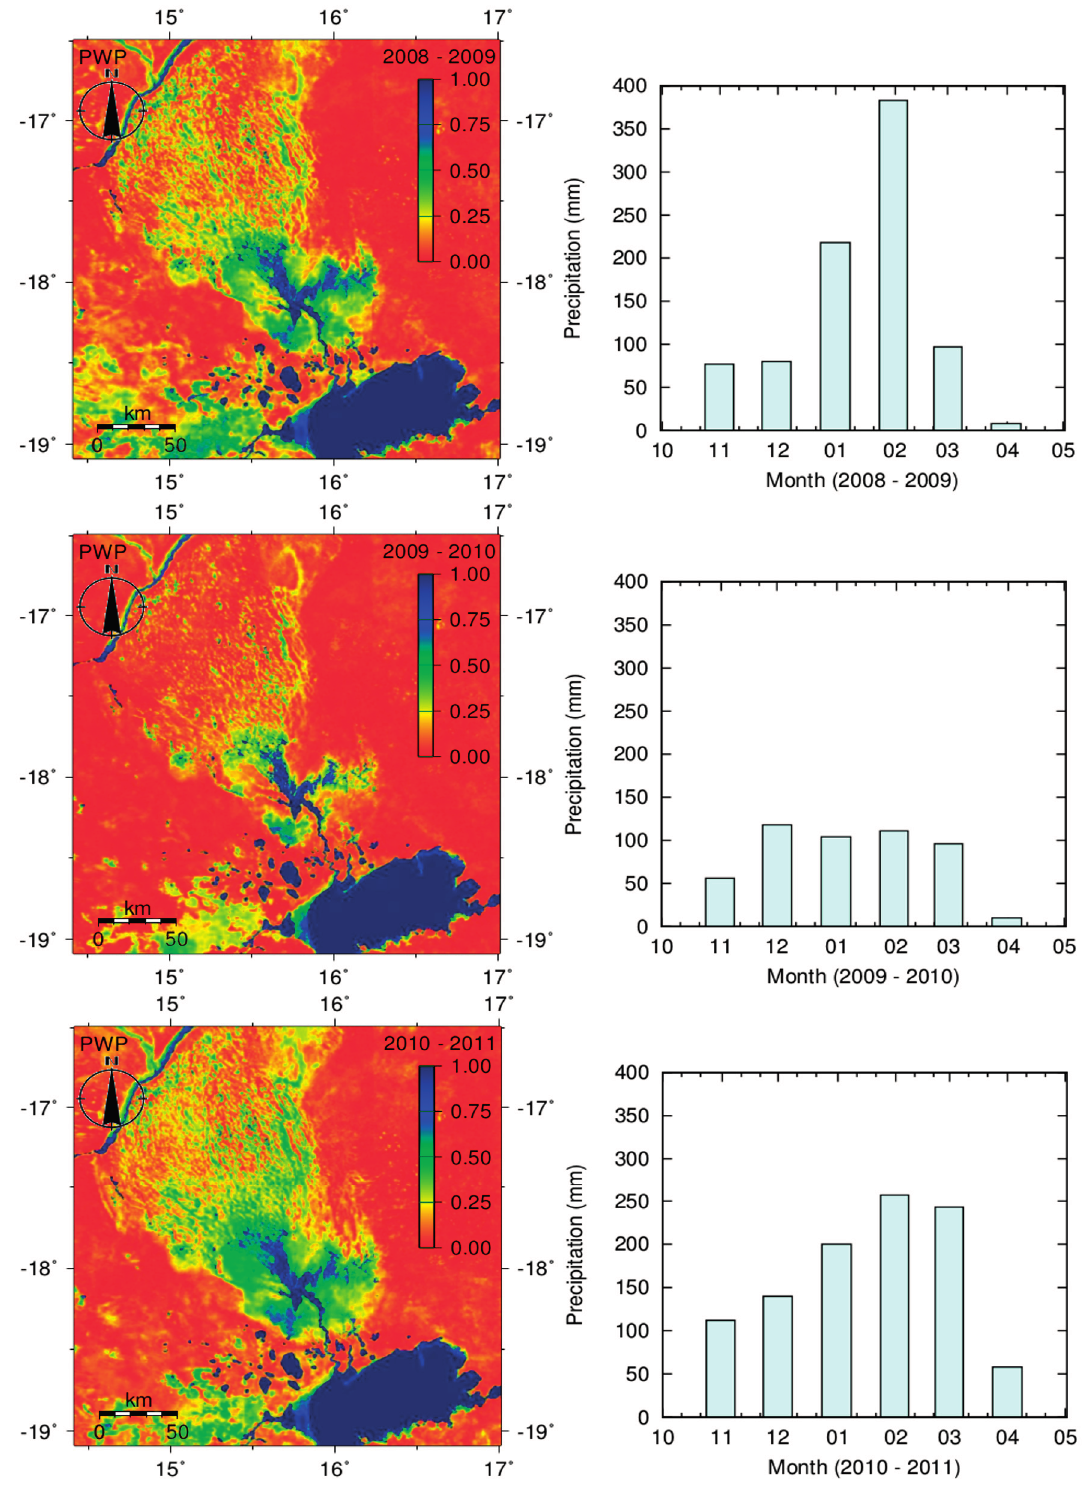
Figure 11. Probability of water presence (PWP) and precipitation during the rainy season from 2008 to 2011. Precipitation data were from Mendelsohn et al .